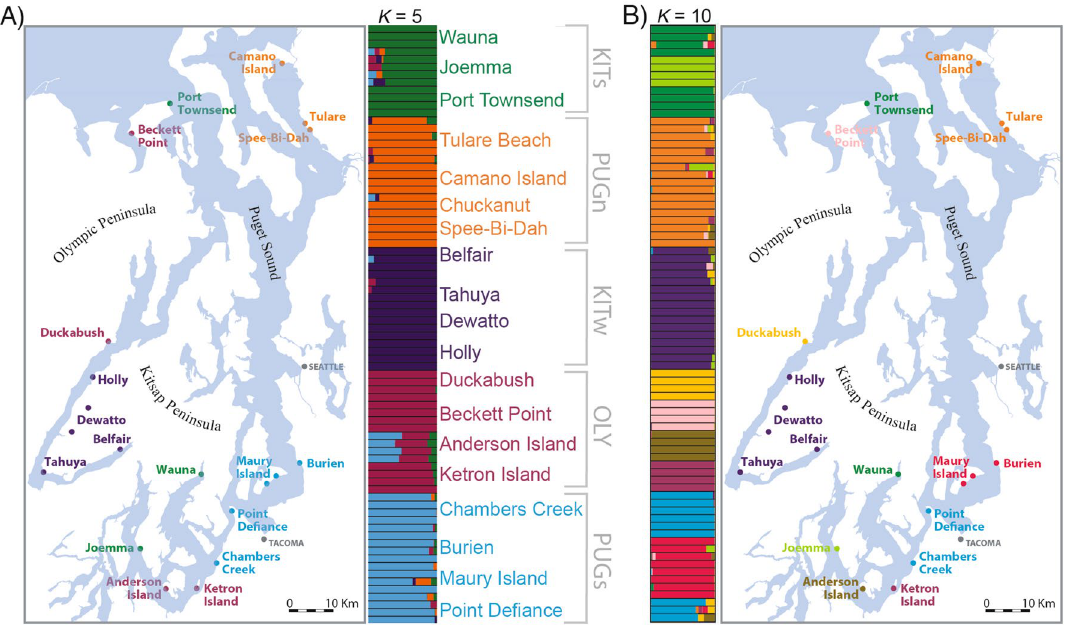
Figure 3. Geographic distribution of populations based on ADMIXTURE analyses assuming a K -value = 5 ( A ) and 10 ( B ). Each bar represents an individual, and the colors indicate the admixture proportions. Results are shown for the 50% missing data dataset (3491 loci). Subpopulation names are assigned using a K -value = 5. KITs Kitsap Peninsula south, PUGn Puget Sound north, KITw Kitsap Peninsula west, OLY Olympic Peninsula, and PUGs Puget Sound south. Maps generated using QGIS 77 .